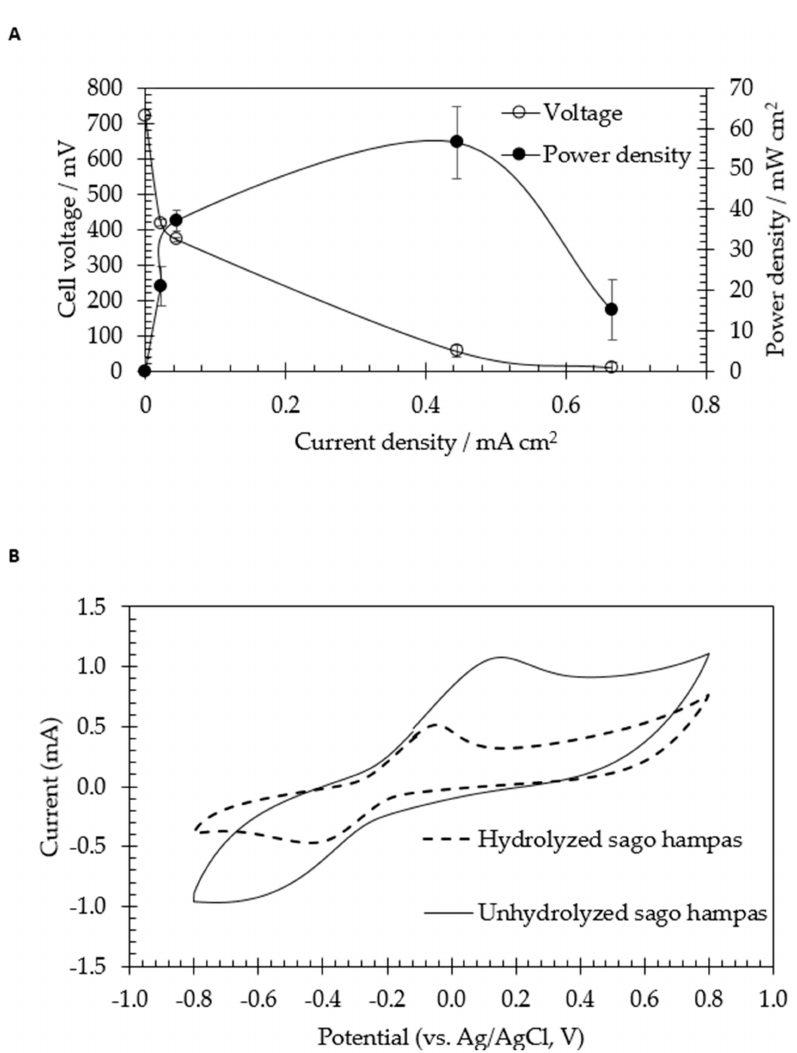
Figure 4. Generation from sago hampas hydrolysate by Clostridium beijerinckii SR1. ( A ) Power density and cell voltage generated from 10 g / L of glucose content in sago hampas hydrolysate as a function of current density. ( B ) Cyclic voltammetry profile of Clostridium beijerinckii SR1 recorded at 96 h after the start of anaerobic fermentation using unhydrolyzed and hydrolyzed sago hampas as substrate. The scan rate was 10 mV /